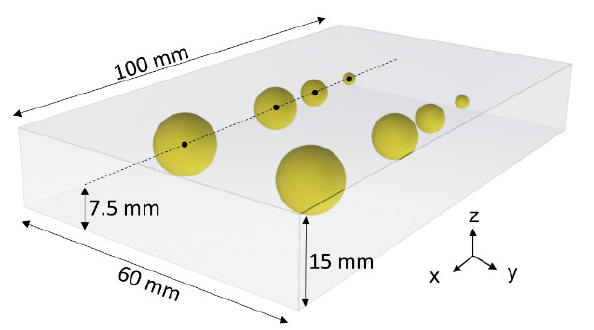
Figure 3. Rendering of the Agar phantom used during the experimental acquisition. The spherical inclusions are marked in yellow ( ∅ 12–9–6–3 mm). The volume of the phantom is 100 × 60 × 15 mm 3 .